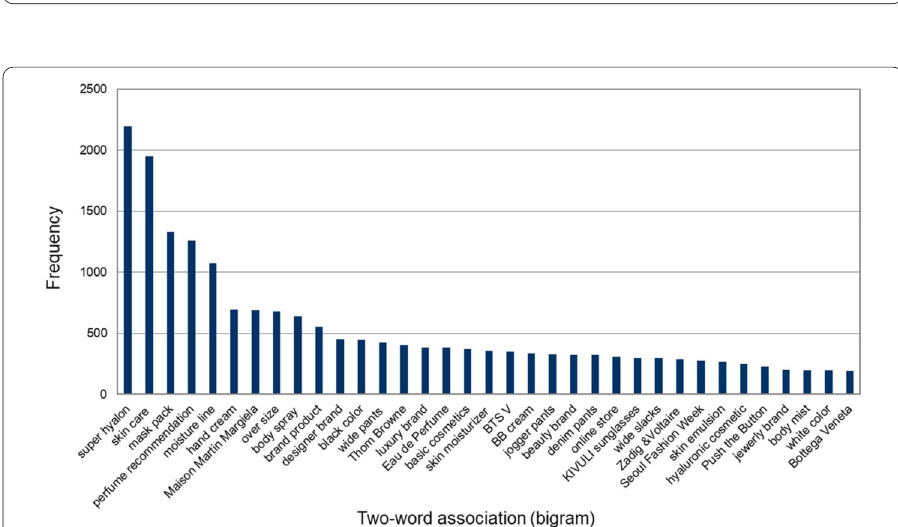
Fig. 5 Results of the bigram